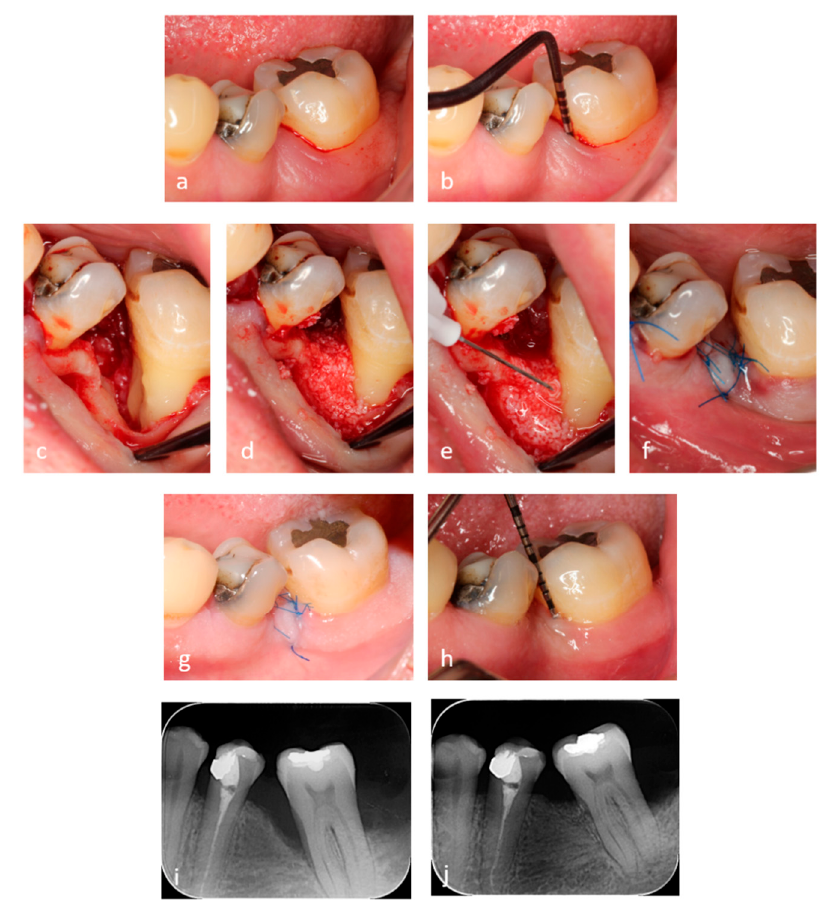
Figure 1. ( a , b ) Preoperative view and a pocket probing depth (PPD) of 9 mm. ( c ) Clinical view of the 1-wall intrabony defect and the instrumented root surface with a thin layer of hyaluronic acid (HA) applied. ( d ) Mixture of HA and xenograft gently packed in the intrabony defect. ( e ) HA layer applied before suturing. ( f ) Passive primary wound closure. ( g ) 14 days healing before suture removal. ( h ) PPD of 3 mm at 6 months. ( i ) Pre-operative radiographic finding. ( j ) Radiographic finding at 6 months.